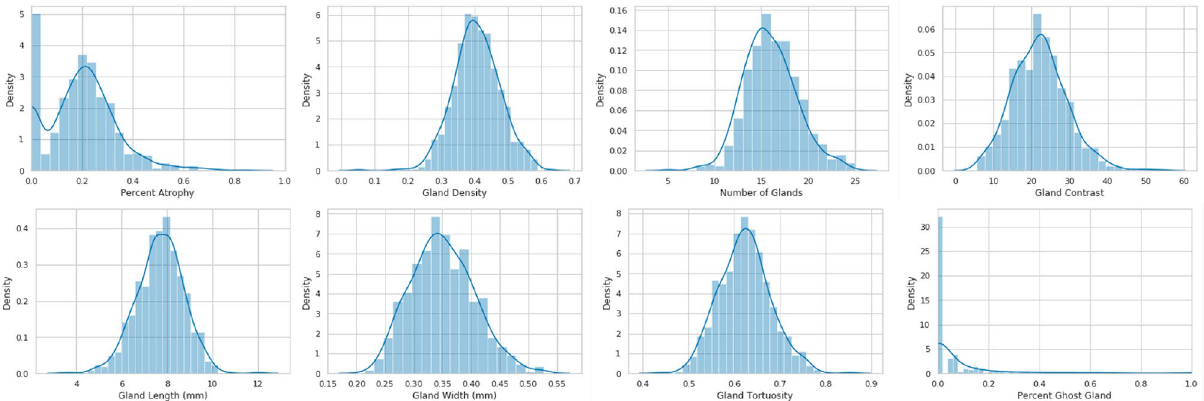
Figure 2. Histograms and density plots of morphological features from meibography images.